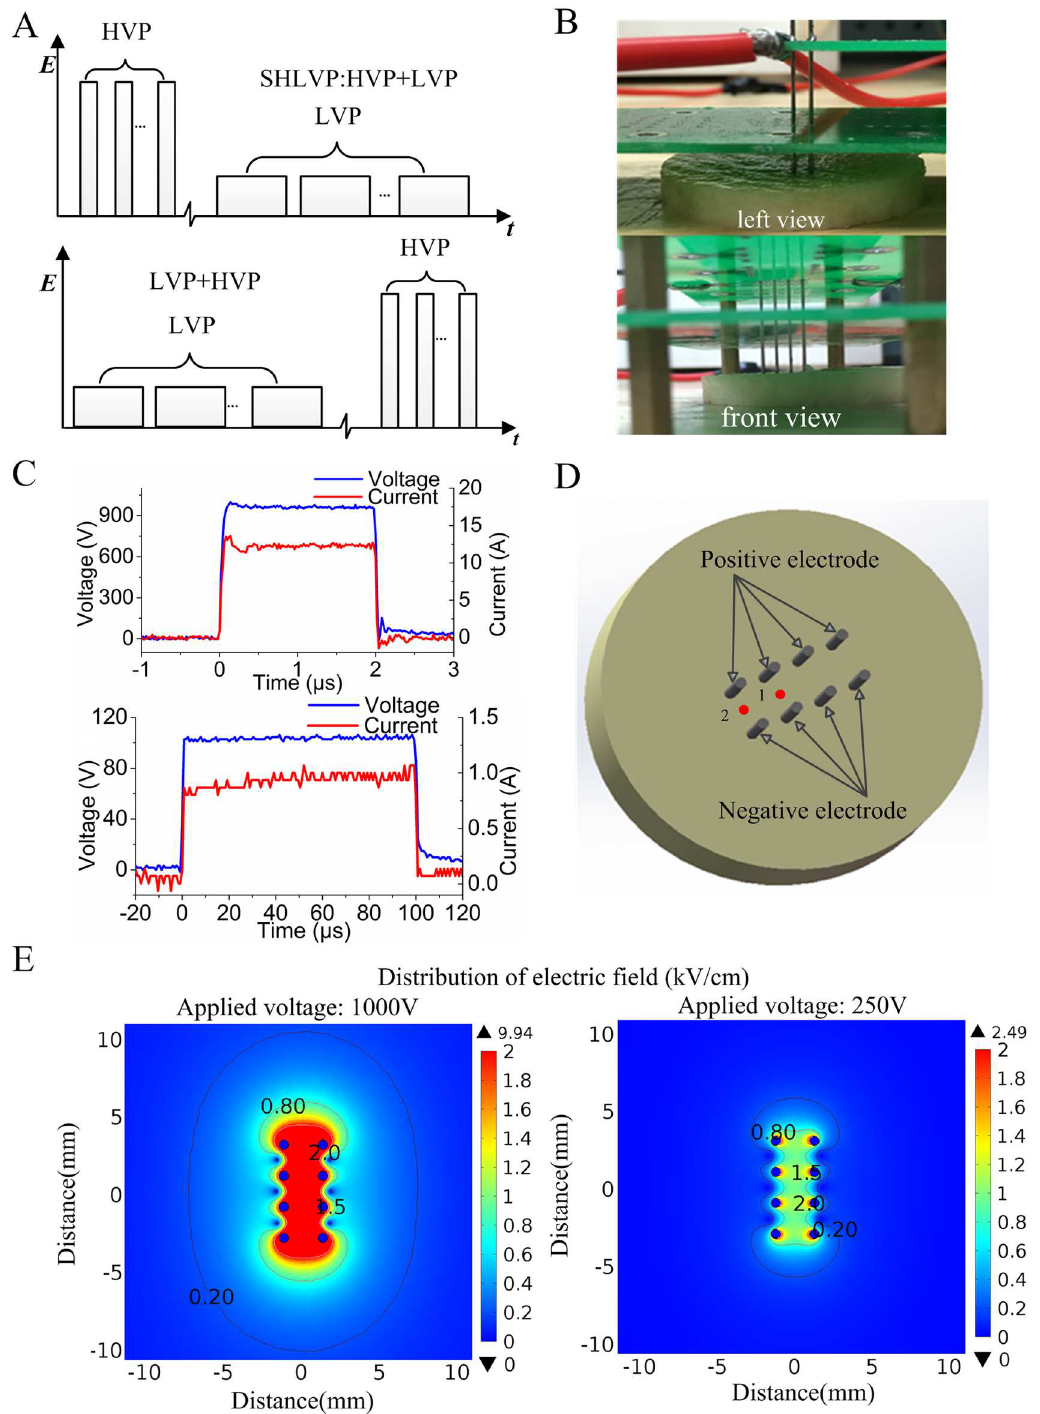
Fig 1. A: Schematic of the protocols. B: Images of the constructionof the experimental electrodes; the left view is shown at the top, and the front view is shown at the bottom. C: Waveforms of 4 kV/cm, 2 μ s (top), and 0.4 kV/cm, 100 μ s (bottom). D: Temperaturemeasurement points (‘1’ and ‘2’) in the potato tissue. E: The distributionof electric field for 1000 V (left) and 250 V (right) applied.